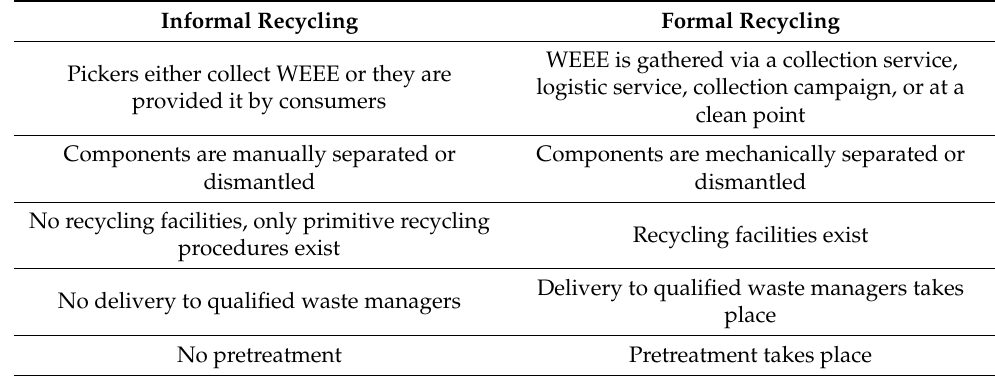
Table 4. Differences between informal recycling in Port Harcourt, Nigeria, and formal recycling in other countries, e.g.,